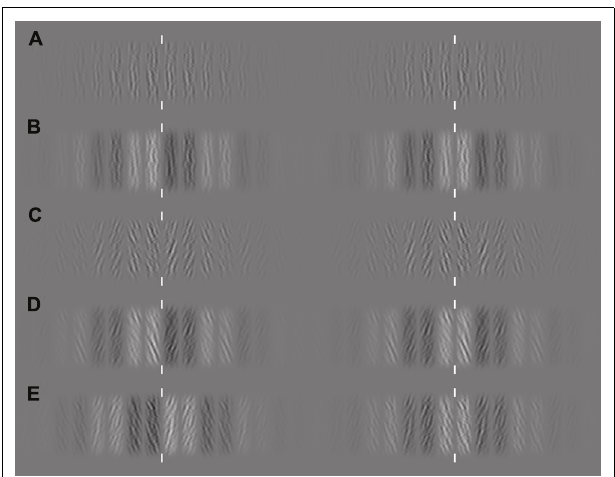
FIGURE 2 | Examples of the experimental stimuli. Since stimuli are periodic, either crossed or parallel fusion of left and right columns will demonstrate the effects of manipulating similarity-based matching.White vertical lines indicate the plane of fixation. Examples of experimental stimuli are shown for each case from Figure 1 . (A) An example stimulus containing no luminance or orientation bias. (B) Matching is biased through manipulation of luminance similarity only. (C) Matching is biased through manipulation of orientation similarity only. (D) Manipulations of orientation and luminance similarity are applied in the same direction. (E) Manipulations of orientation and luminance similarity are applied in opposite directions.